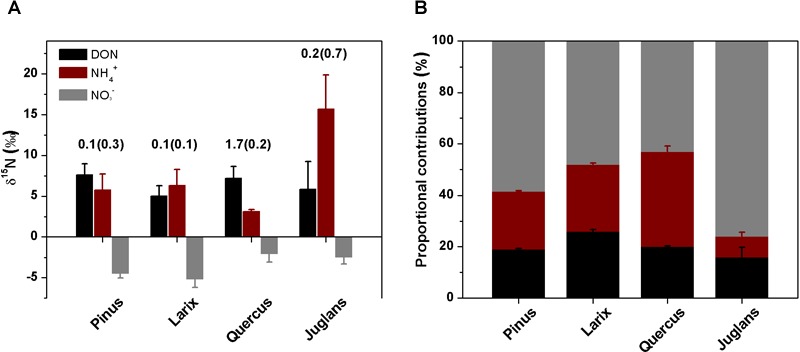
δ15N values (A, ‰) of soil DON, ammonium, nitrate (bars, means ± SE) and of leaves after corrected for the 15𝜀 (numbers above the bars) and the estimated proportional contributions (B, %, means ± SD) of the three N forms to plant N nutrition of the four taxa Pinus, Larix, Quercus, and Juglans using an isotope mixing model (see section “Materials and Methods”).